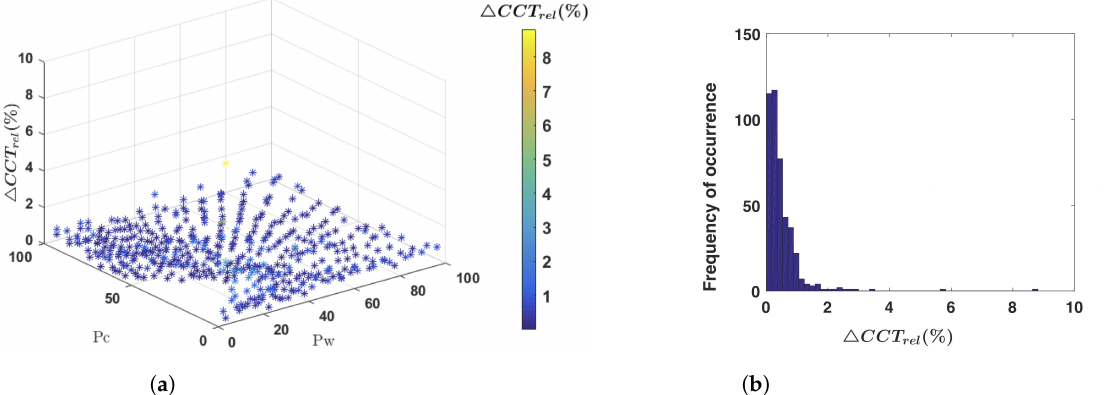
Figure 9. Results of the testing phase: ( a ) distributions of the relative percentage differences of parameter between the expected and measured CCT as a function of the input power for the test point; ( b ) Histogram of the relative percentage differences calculated for the test point of the two LED light